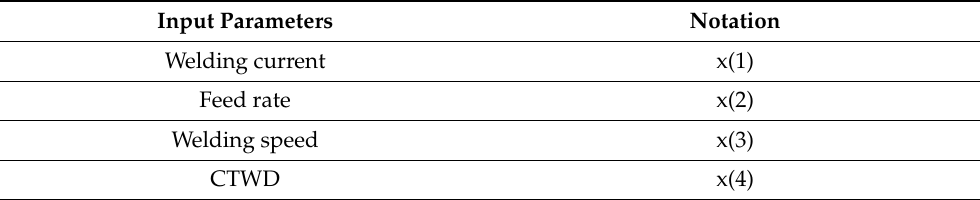
Table 5. Notation for input parameters.